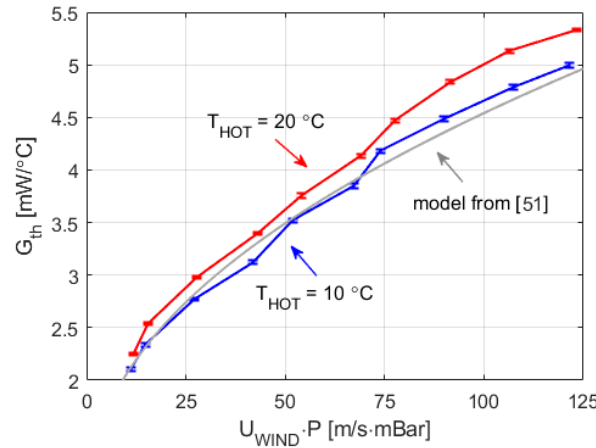
Figure 10. Overall convective heat transfer coefficient, as a function of the product of the wind velocity and pressure, for the experiment of Figures 6 and 7, including the 1 σ error bars associated with the noise of the samples. The solid-grey line is the result of evaluating the correlation (6) [51], at T = 300 K for the values of our experiment.